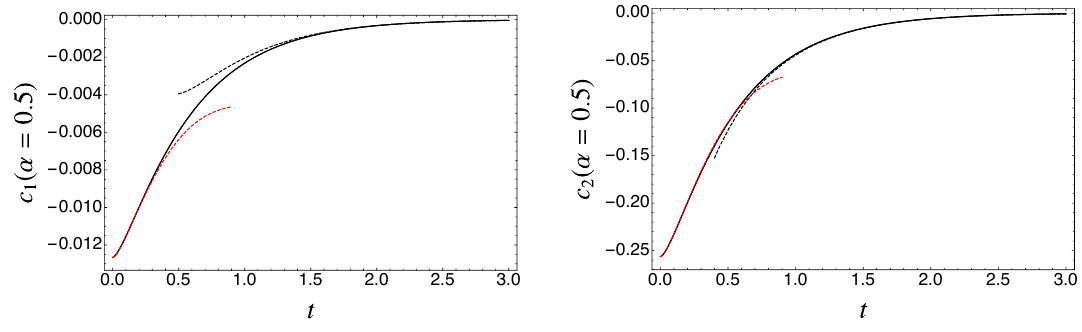
Figure 7 . The solid lines are the functions c n ( (cid:11) ) obtained as exact numerical solutions of the di(cid:11)erential equation (4.6). The dashed lines are the leading terms in the expansions for short (red) and long (black) distances, i.e. eqs. (4.11) and (4.29),